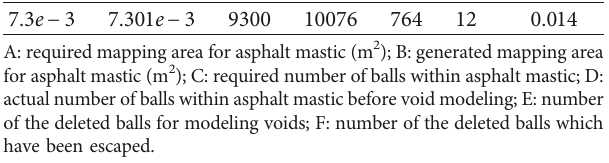
Burger’s models. One is the contact point within asphalt, and another is between the asphalt mastic and aggregates.